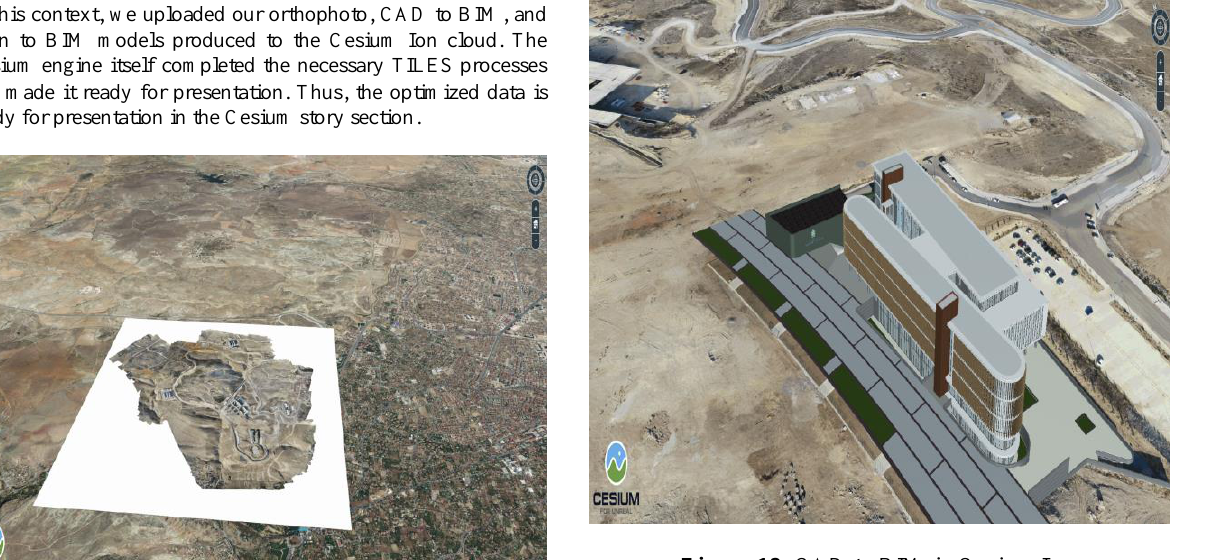
Figure 13. CAD to BIM in Cesium